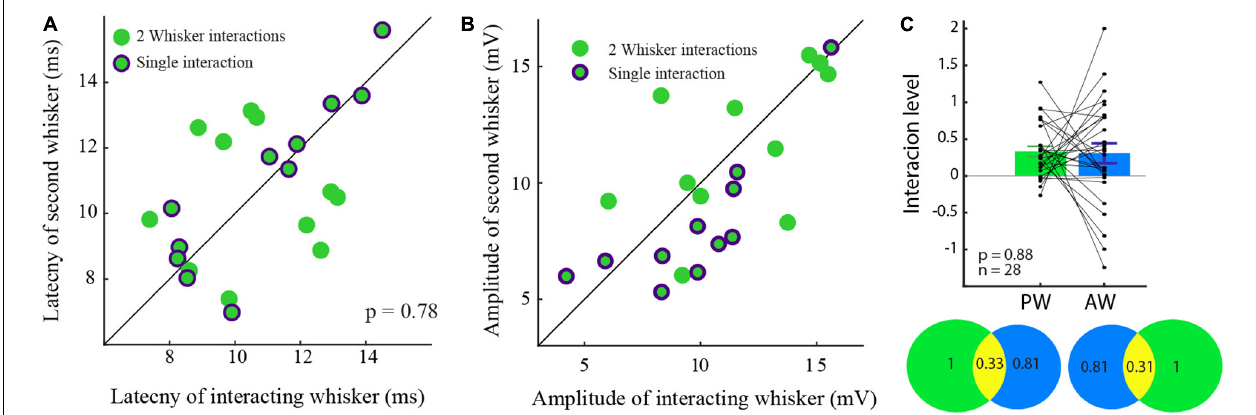
FIGURE 5 | Similar latency and amplitude for unidirectional and interacting cells. (A) The latency to the response of the two cell groups was not significantly different. (B) The amplitude ratio of the two cell groups was similar. (C) The level of input-interaction between the whiskers was not dependent on the response amplitude. The level of interactions between PW and the AW evoked inputs in the bar plot is summarized in the Venn diagram showing the interactions (yellow) between for the PW (green), and the AW (blue) inputs which are